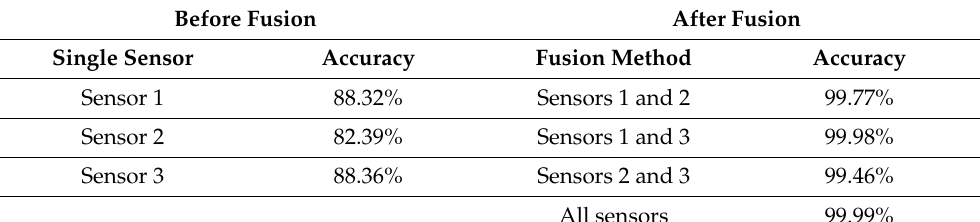
Table 3. Accuracy comparison before and after single-channel